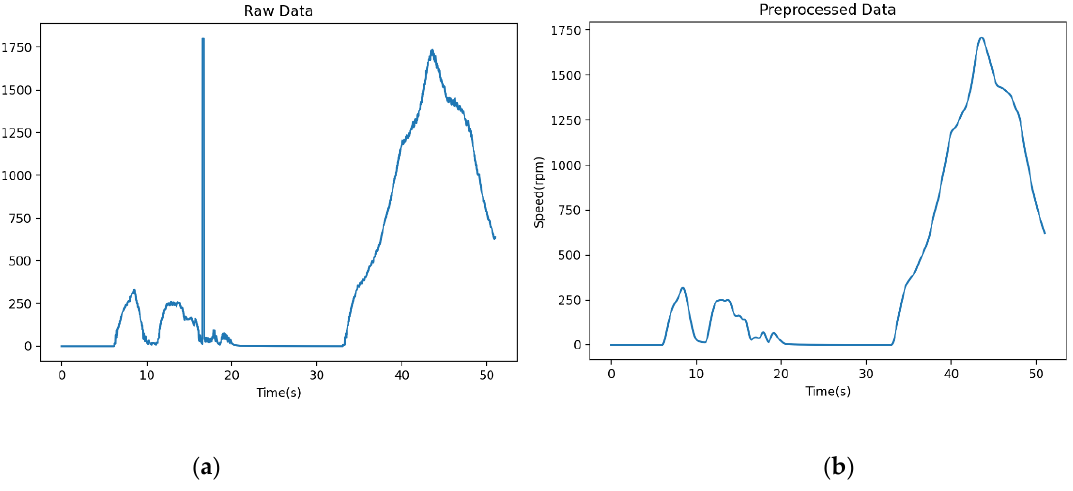
Figure 4. Comparison before and after speed preprocessing: ( a ) Raw Data, and ( b ) Preprocessed